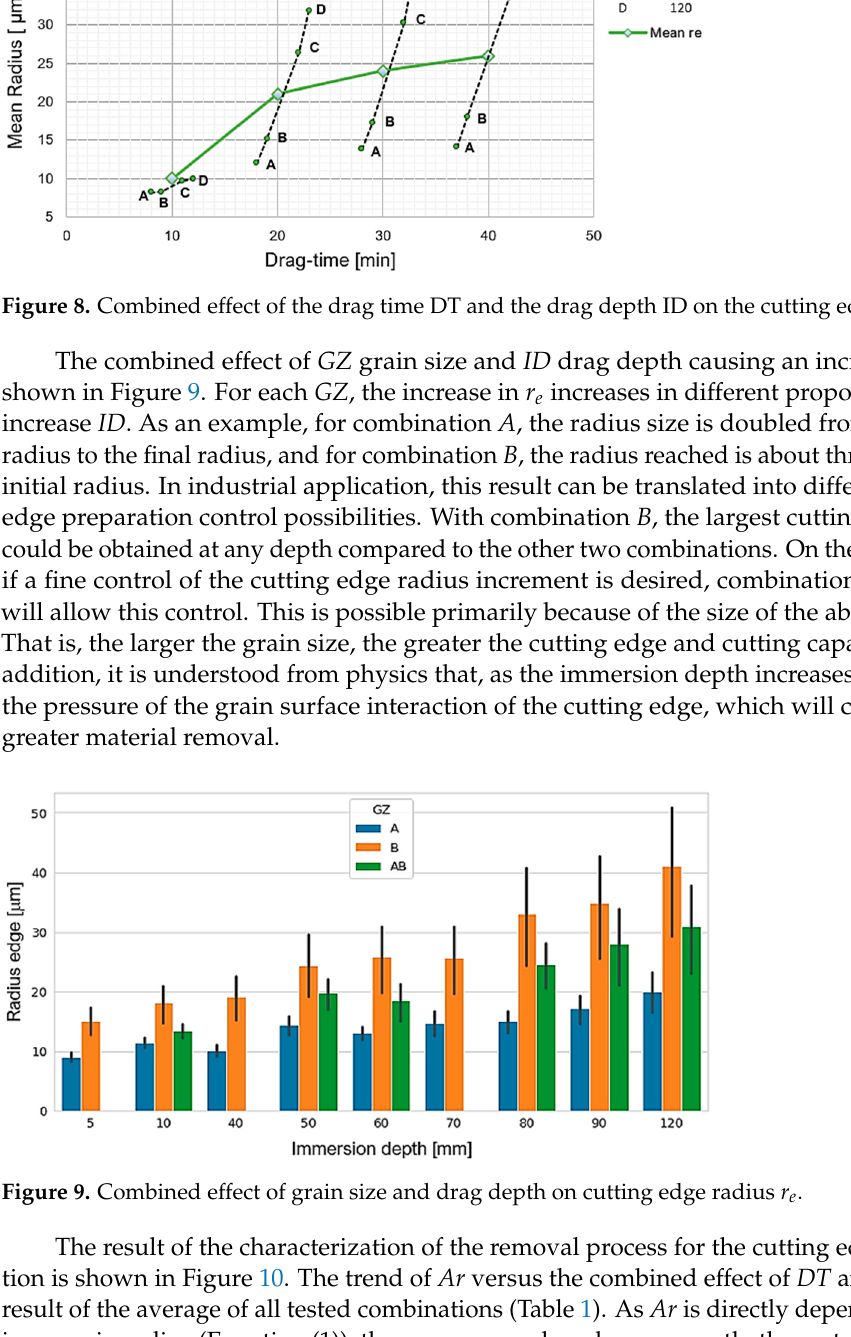
Figure 10. Material removal area of the three abrasive blends with time variation. 3.2. Surface Roughness Analysis at the Cut Edge Residual surface defects from the manufacturing process at the edges can reduce the quality of a workpiece. By applying the drag finishing process, these imperfections are eliminated and reduced, as in the case of surface roughness (Figure 11). Consequently, it will provide a smooth subsequent finishing and better handling.